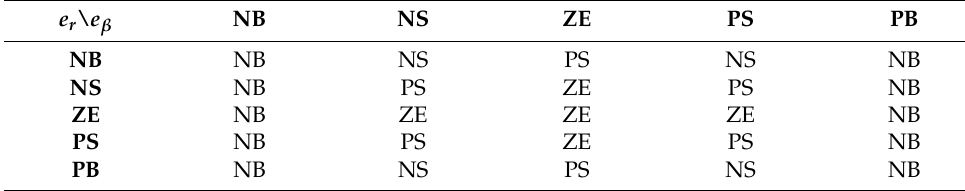
Table 3. Adjustment rules Fuzzy Rule Table.